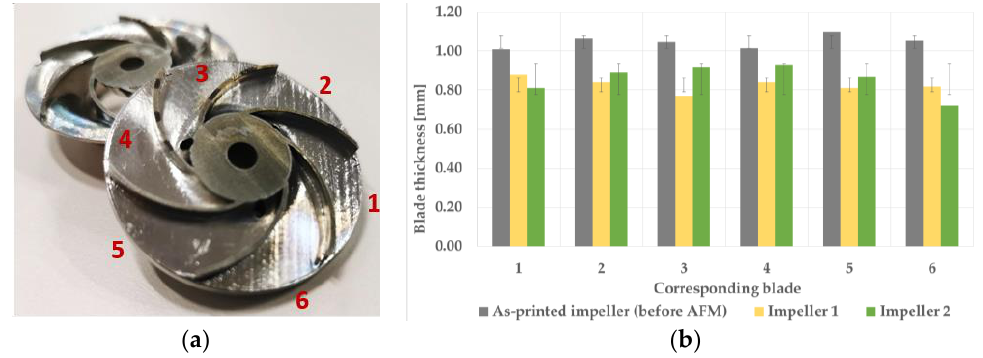
Figure 12. Blade thickness evaluation after AFM process: ( a ) halved AM closed impeller; ( b ) blade